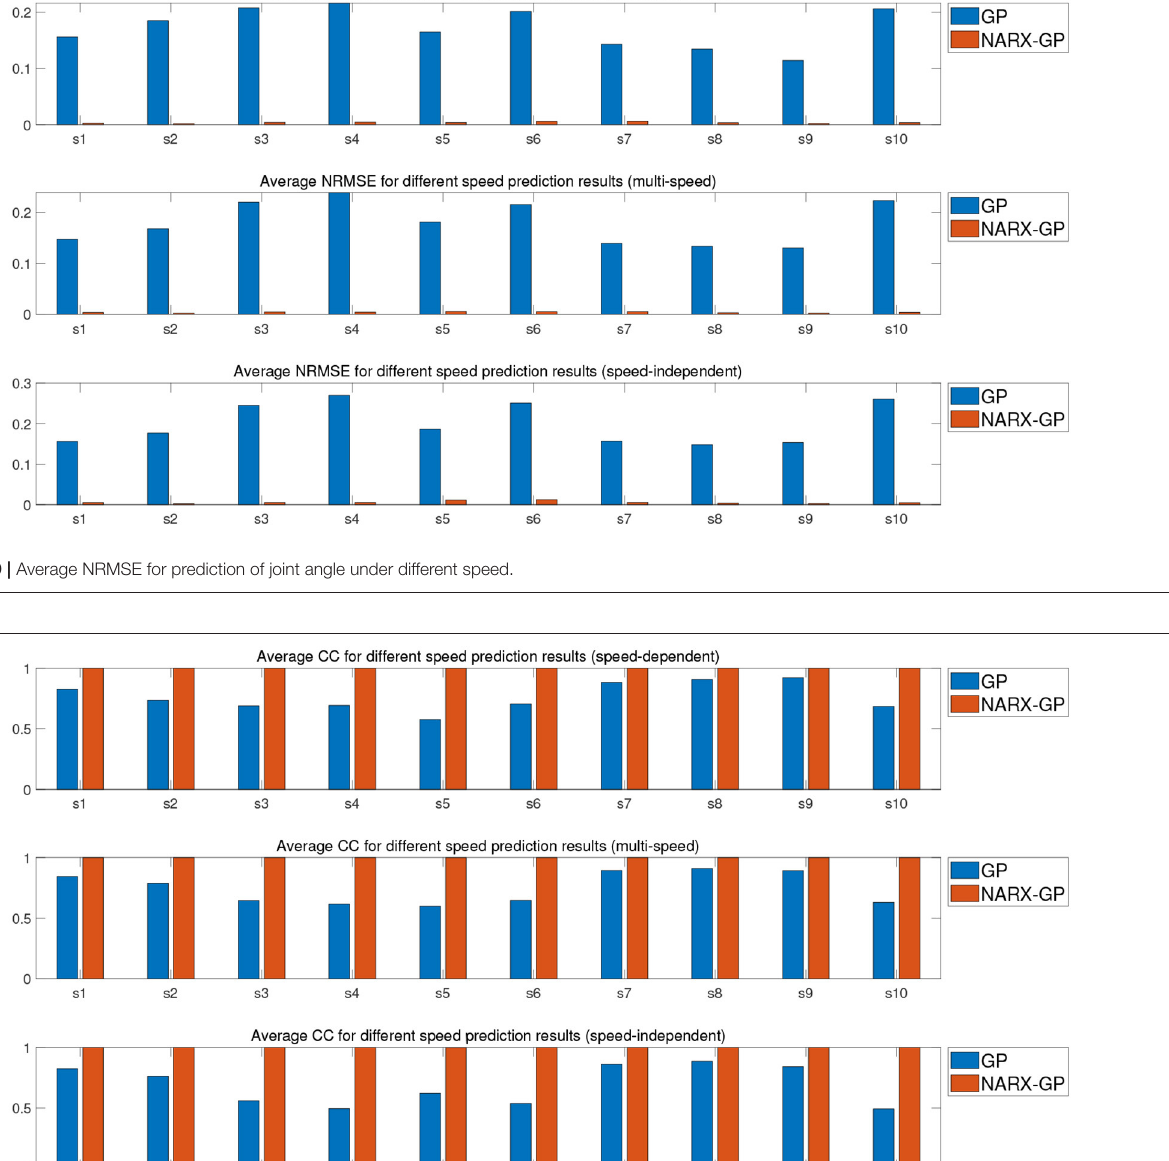
The means and standard deviations of NRMSE and CC between predicted and actual values of joint angles for all subjects in speed-dependent, multi-speed and speed- independent conditions are shown in Tables 1 , 2 . From Tables 1 , 2 , it can be seen that the predictions of the